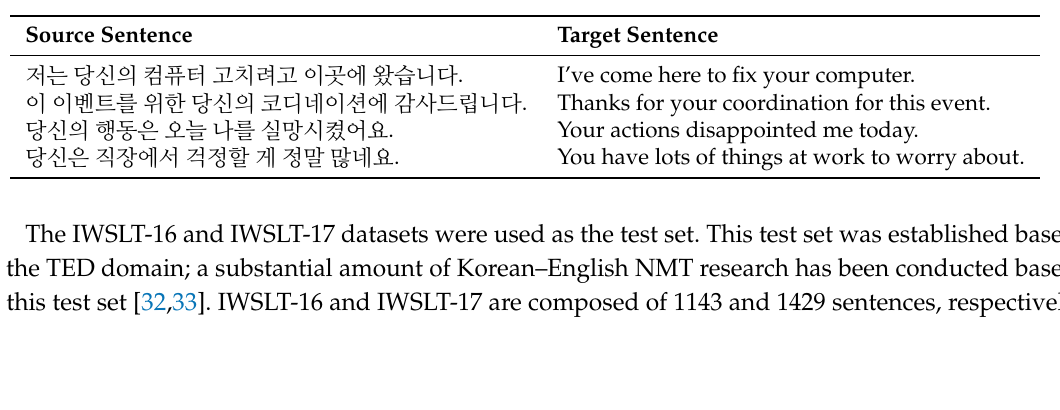
Table 1. Training data